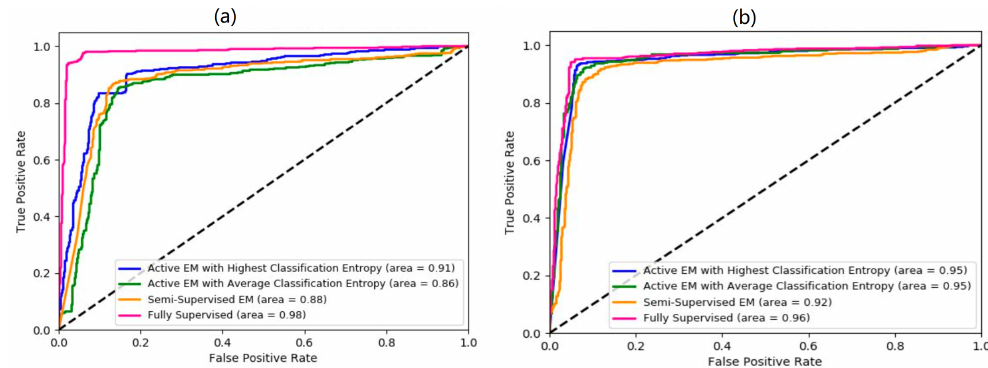
Figure 9. Active phase: 10 labels per iteration for the NLST dataset using ResNet34 with ( a ) 25% and ( b ) 50% of initial